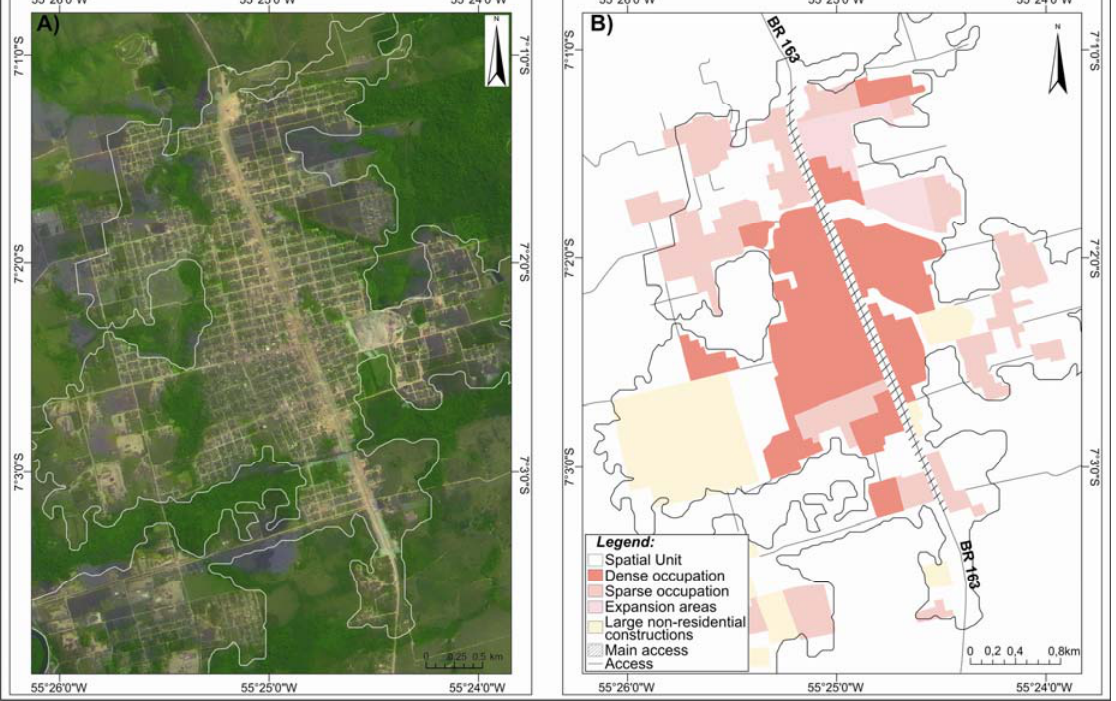
Table 5. Categories of spatial units of human occupation mapped and evaluated during fieldwork. Spatial